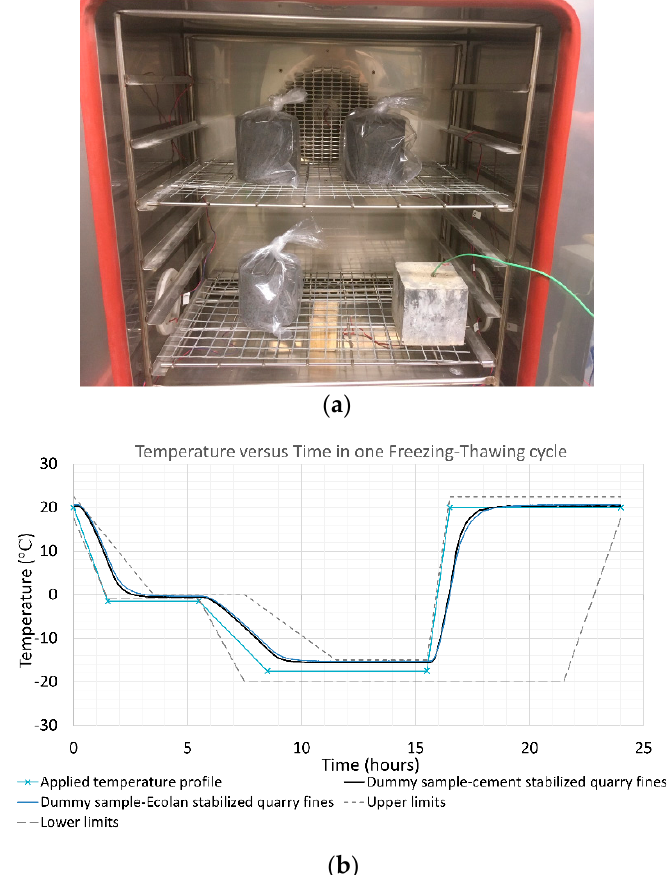
Figure 8. Freeze–thaw test: ( a ) Stabilized quarry fine specimens inside the chamber; ( b ) Temperature profile applied in freeze–thaw cycles.